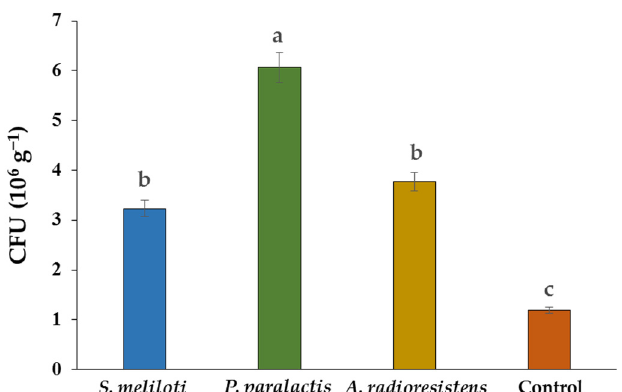
Figure 3. Rhizobacterial population on C. sativus L. Different letters indicate a significant difference ( p < 0.05) according to Tukey’s test.